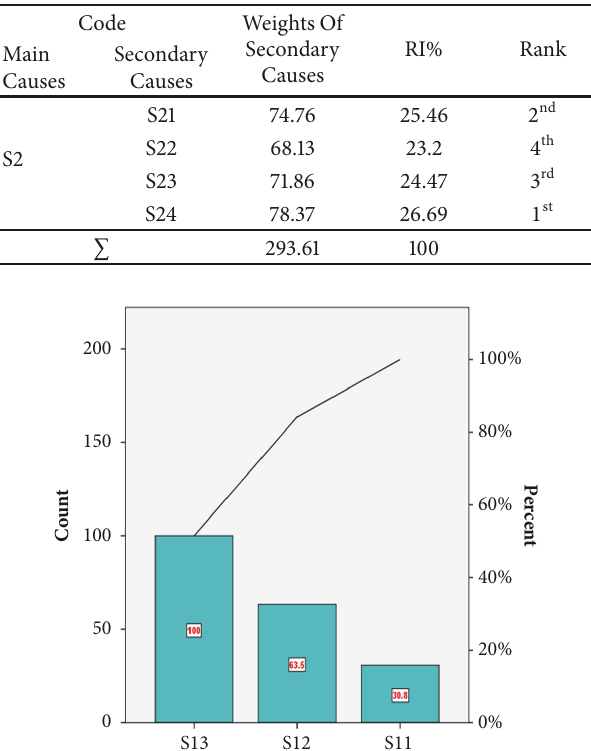
Table 5: Main causes weights, relative importance, and rank for project planning management process group.